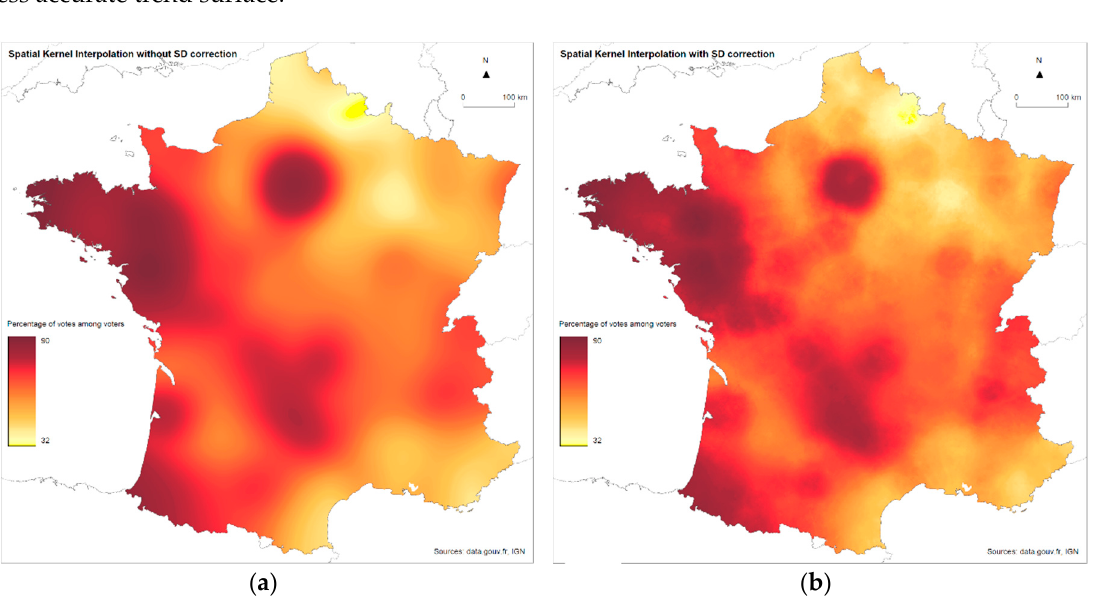
Figure 6. Spatial kernel interpolation (Gaussian function, h = 200 km) applied to the votes for Emmanuel Macron at the second round of presidential elections in France (2017): ( a ) Left map without SD-correction; ( b ) Right map with SD-correction.